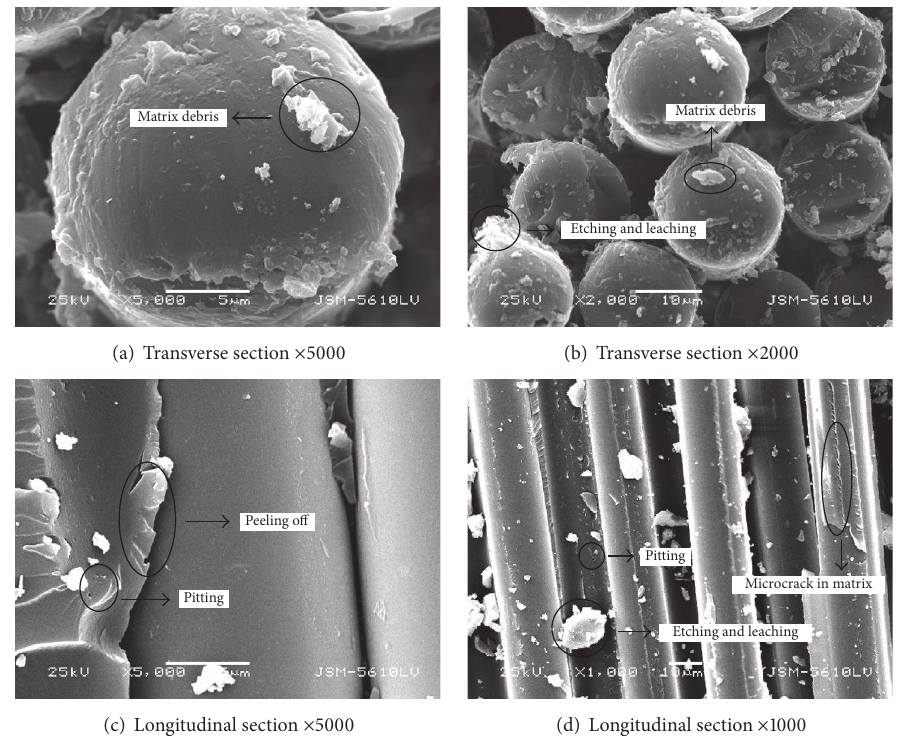
Figure 4: Microstructure morphology of GFRP bars in the steam-curing